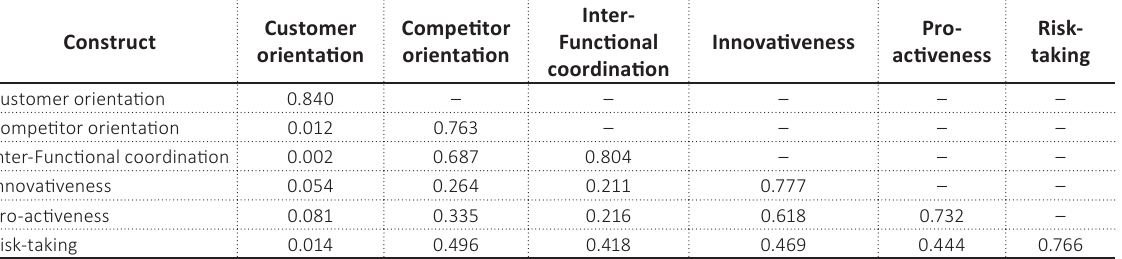
Table 3. Fornell-Larcker criterion